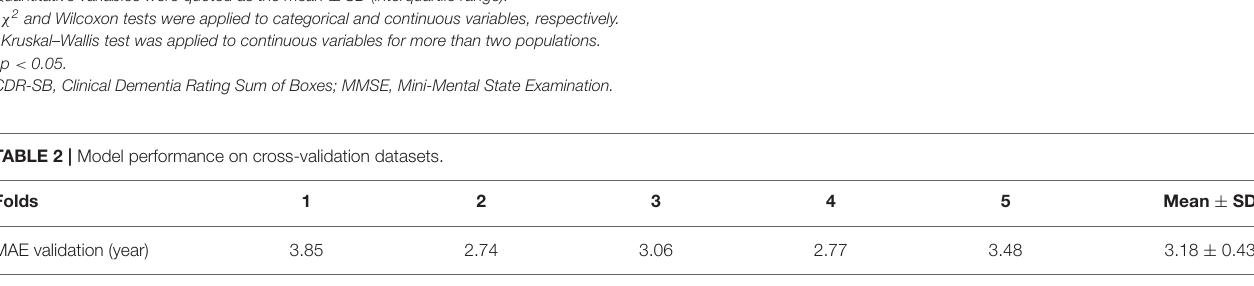
MAE, mean absolute error; SD, standard